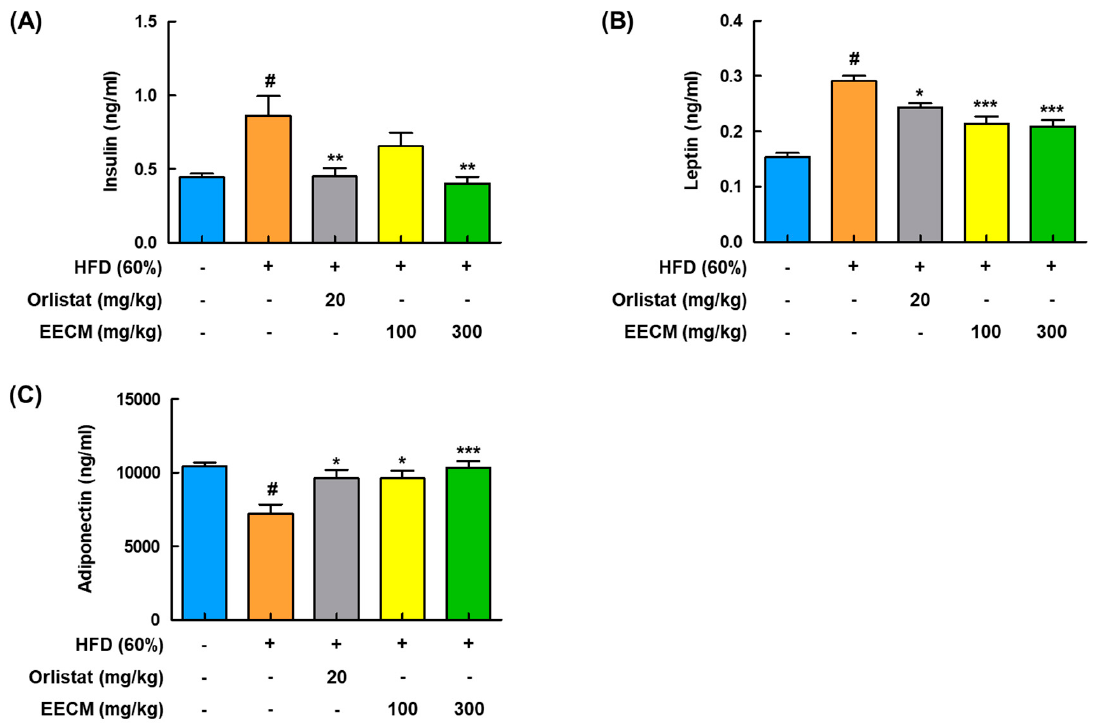
Figure 6. Regulatory effect of EECM on the production of adipocyte-released hormones in HFD (60%)-induced obese mice. Plasma levels of ( A ) insulin, ( B ) leptin, and ( C ) adiponectin were detected using ELISA kit. Values are represented as the mean ± SEM ( n = 8/group). # p < 0.05 vs. the CON group; * p < 0.05, ** p < 0.01, and *** p < 0.001 vs. the HFD (60%)-induced obese group. Table 1. Effects of the ethanol extract of Cassia mimosoides var. nomame Makino (EECM) on the lipid parameters in HFD (60%)-induced obese mice.